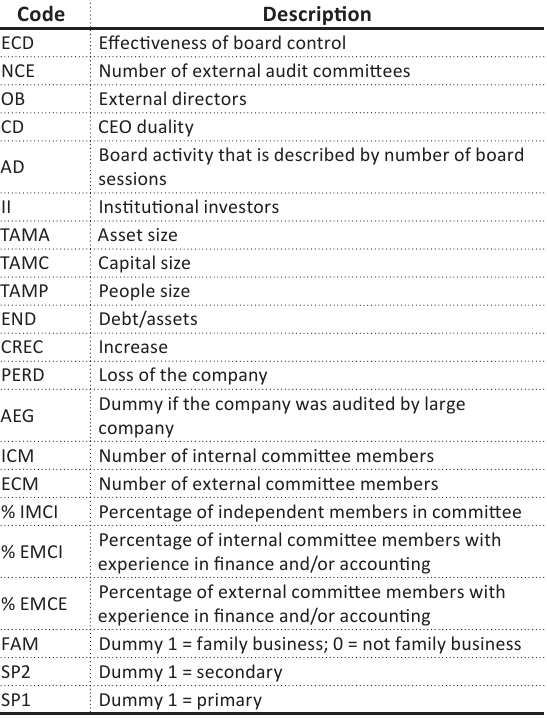
Table 2. Cronbach’s alpha coefficient per construct Table 3. Description of model